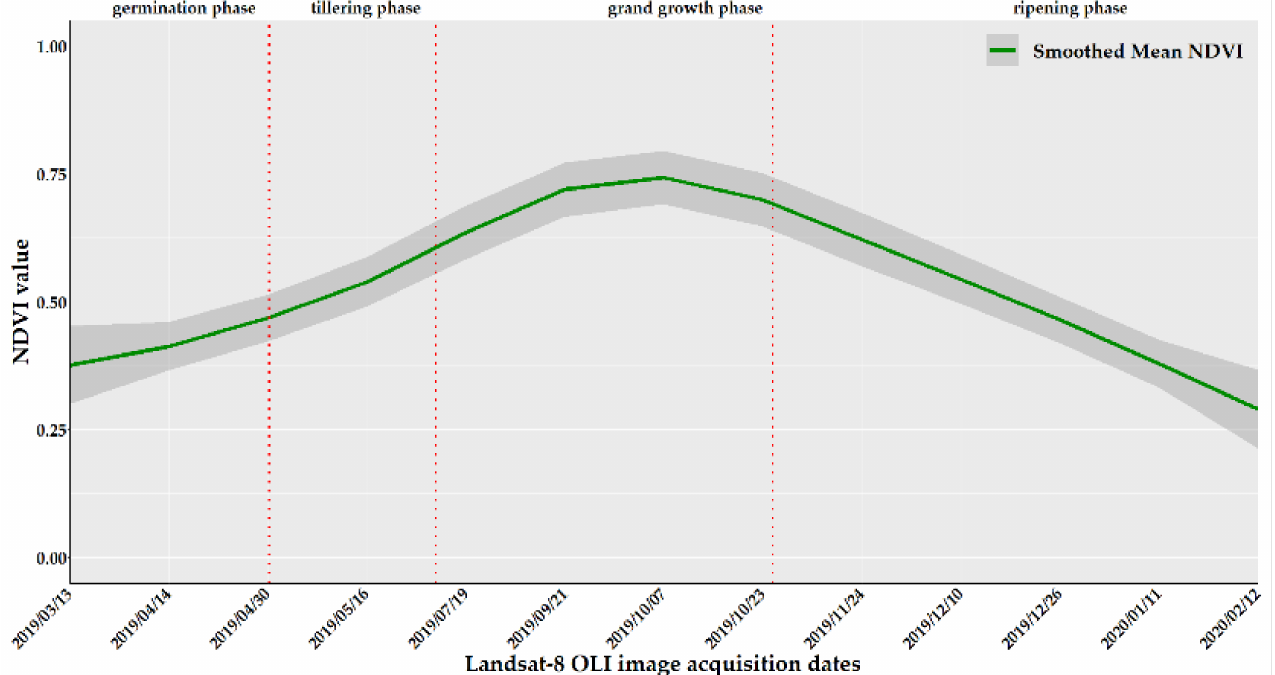
Figure 8. Example of the smoothed mean normalized difference vegetation index (NDVI) prolife (green line) of sugarcane crop in 2019/2020, Udon Thani province, Thailand. The smoothed line of mean NDVI is presented in the dark area. The dot lines at vertical axis are separated in different sugarcane